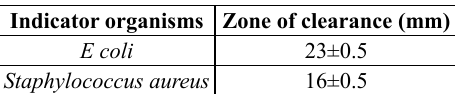
table 2. Antimicrobial property of essential oil against indicator organisms Indicator organisms Zone of clearance